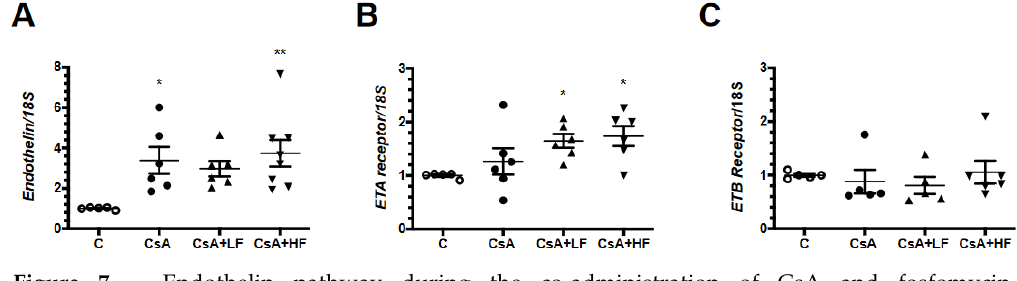
Figure 7. Endothelin pathway during the co-administration of CsA and fosfomycin. ( A ) Prepro-endothelin , ( B ) ETA receptor, and ( C ) ETB mRNA levels in control (C, white circles), cyclosporine (CsA, black circles), CsA with a low dose of fosfomycin (CsA + LF, black triangles up), and CsA with a high dose of fosfomycin treated rats (CsA + HF, black triangles down). n = 6. * p < 0.05, ** p < 0.01 vs. control group.